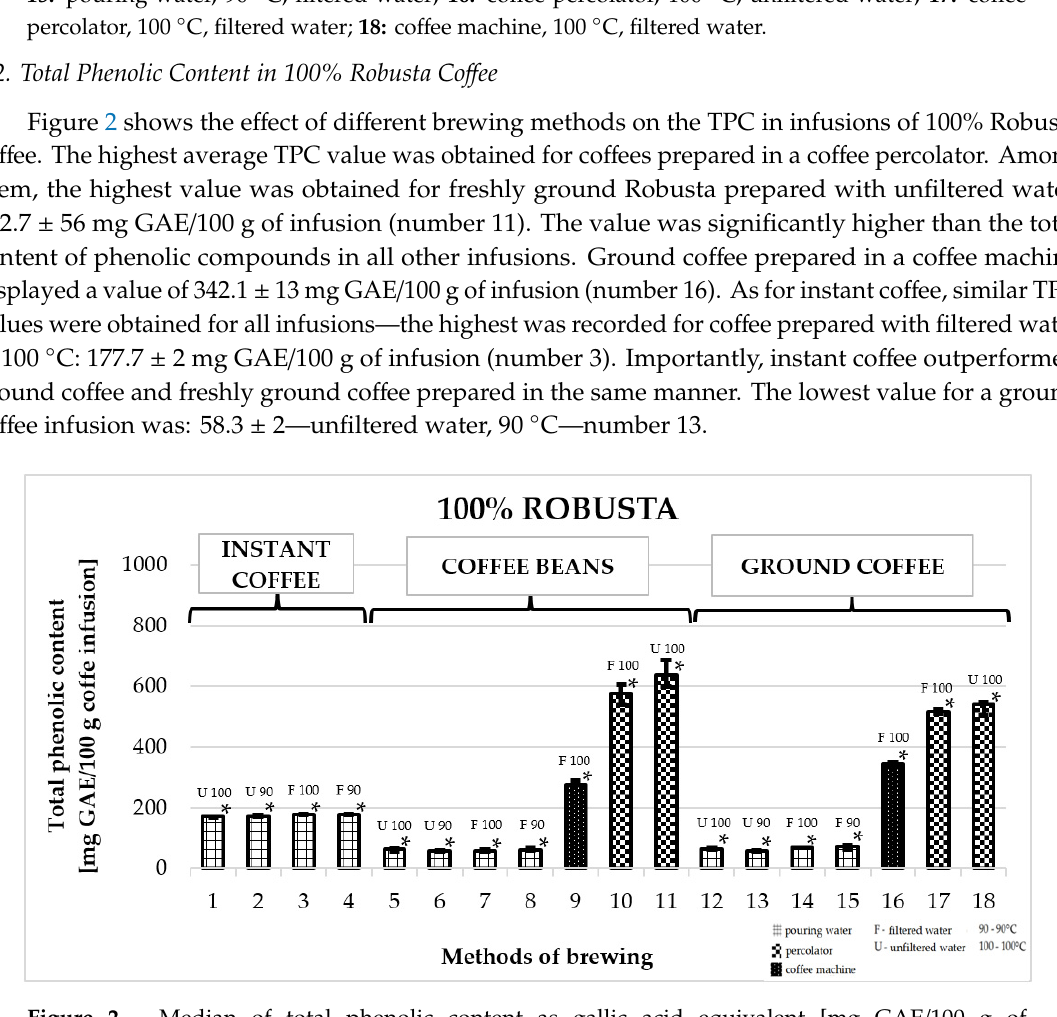
Figure 2. Median of total phenolic content as gallic acid equivalent [mg GAE/100 g of infusion] in